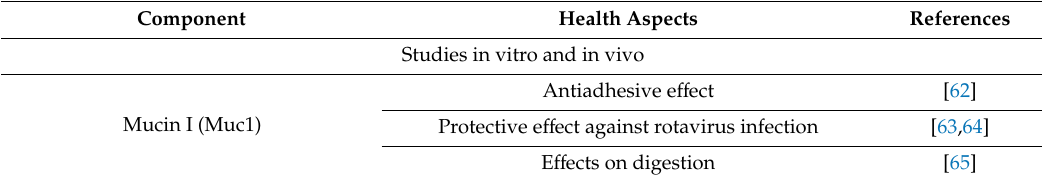
Table 3. Biological studies of MFGM proteins (Adapted from ref